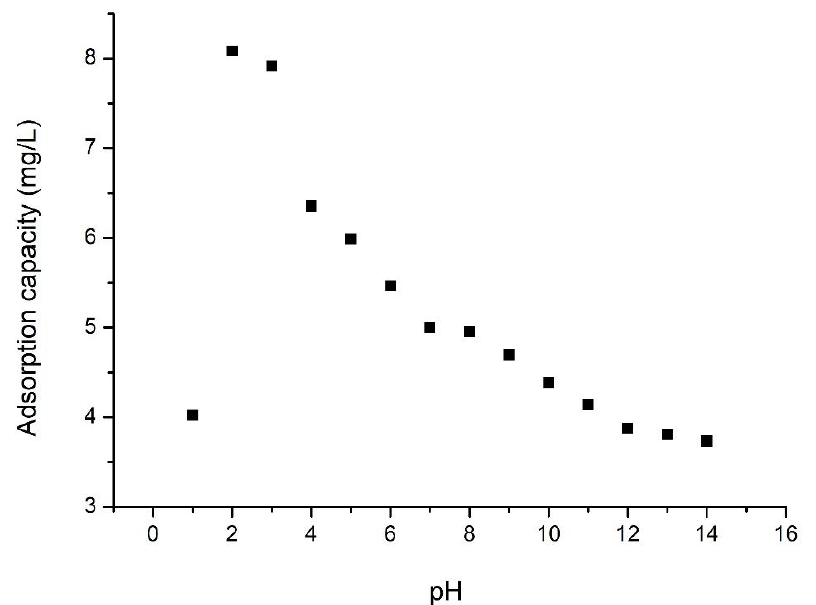
Figure 6. Effect of pH on the adsorption mount of vanadium (V).